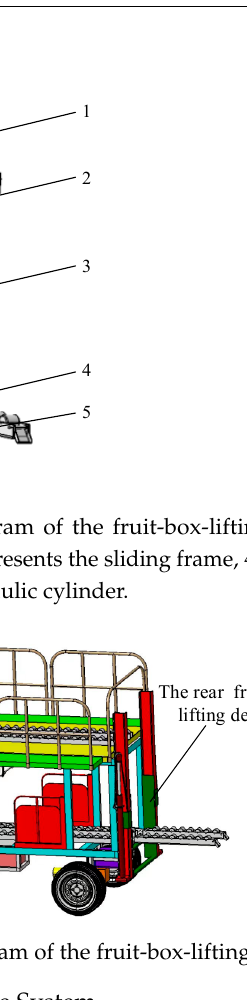
Figure 8. Installation diagram of the fruit-box-lifting device.